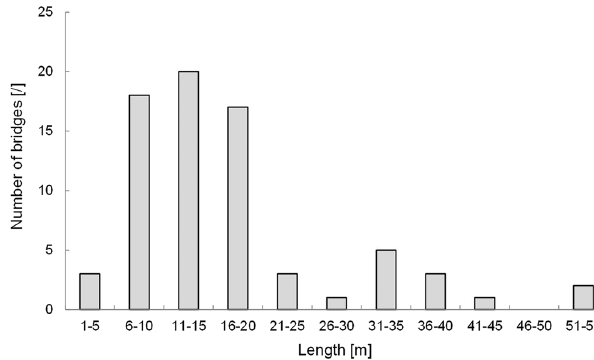
Figure 5. Length of 70 LRBs (with 73 measured